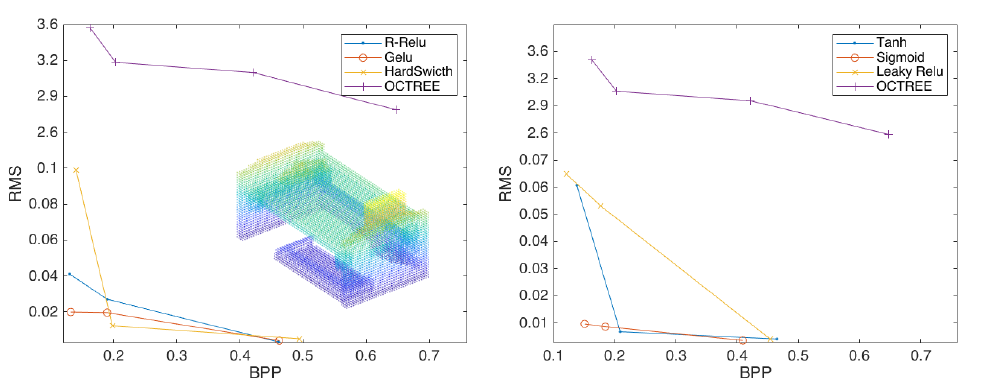
Figure 9. The compression performance of the scheme configured with three layers of convolution and two strides using the activation functions R-Relu , Gelu , and HardSwitch ( left ) and Tanh , Sigmoid, and Leaky Relu ( right ).